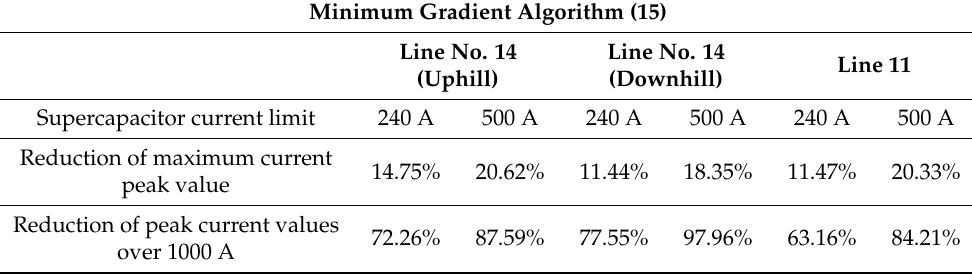
Table 4. Comparison of percentage reduction of current peak values using the minimum gradient algorithm and without